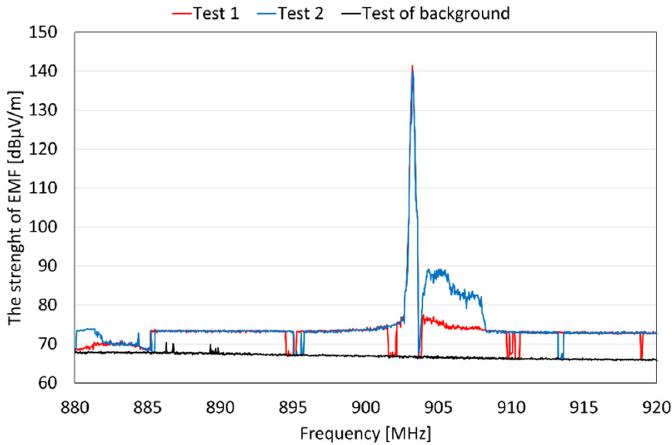
Figure 2. Measurement results of electromagnetic field strength generated from a device built on Arduino UNO at a distance of 0 cm.